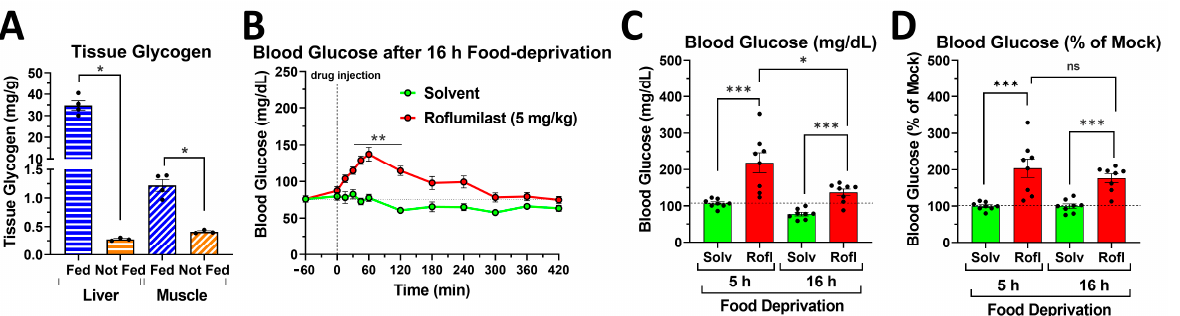
Figure 7. Glucose release from hepatic glycogen is not required for the glycemic effects of PAN-PDE4 inhibitors. ( A ) The glycogen levels in the liver and skeletal muscle (gastrocnemius) of fed mice (which were given 4 g/kg glucose o.g. at 60 min prior to euthanasia and tissue extraction) and of mice deprived of food for 16 h overnight (Not Fed) are shown. ( B – D ) Mice were food-deprived for 16 h overnight prior to treatment with either the PAN-PDE4 inhibitor roflumilast (Rofl; 5 mg/kg; i.p.; n = 8) or solvent control. ( B ) Shown is the complete time course of blood glucose levels in mice deprived of food for 16 h overnight after treatment with roflumilast or solvent control. ( C , D ) Comparison of blood glucose levels at 60 min after treatment with roflumilast or solvent control (Solv) in mice food-deprived for 5 h (data extracted from Figure 1) or in mice food-deprived for 16 h overnight (data extracted from Figure 7B). Data are reported as either the amount of blood glucose in mg/dL( C ) or as a percentage of the solvent control ( D ). All data represent the mean ± SEM. Statistical significance was determined using the Mann–Whitney test (bar graphs) or a two-way ANOVA with Sidak’s post hoc test (time courses) and is indicated as ns ( p > 0.05); * ( p < 0.05); ** ( p < 0.01); and *** ( p < 0.001).